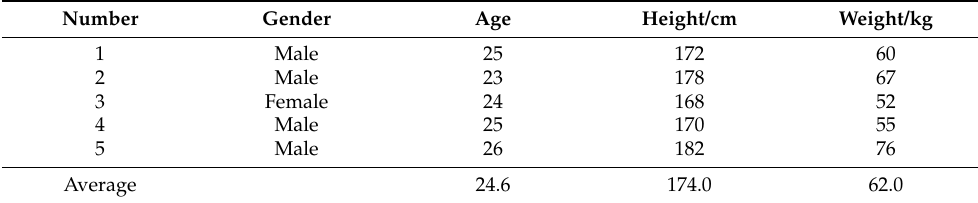
Table 1. Basic parameters of the testers.